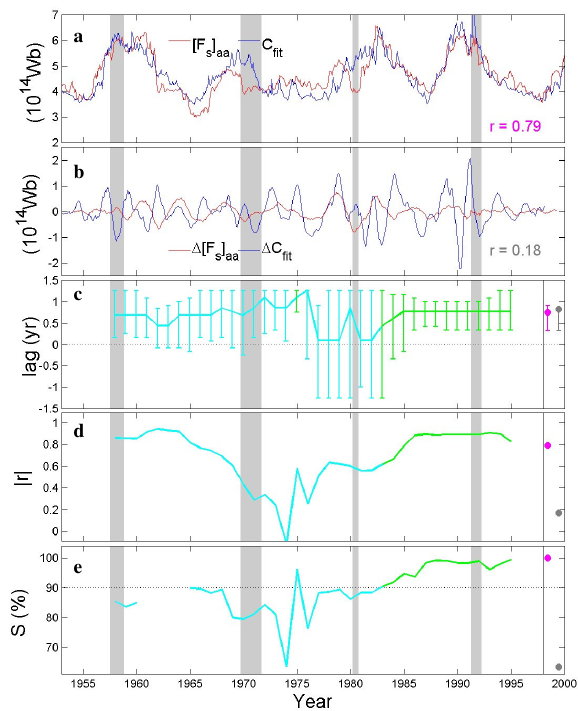
Fig. 8. The same as Fig. 7, for the correlation analysis of Climax neutron monitor ( > 3GV) counts C and the open solar flux deduced Figure 8. The same as figure 7, for the correlation analysis of Climax neutron monitor (>3GV) from the geomagnetic aa index [ Fs ] aa counts C and the open solar flux deduced from the geomagnetic aa index [Fs] aa .